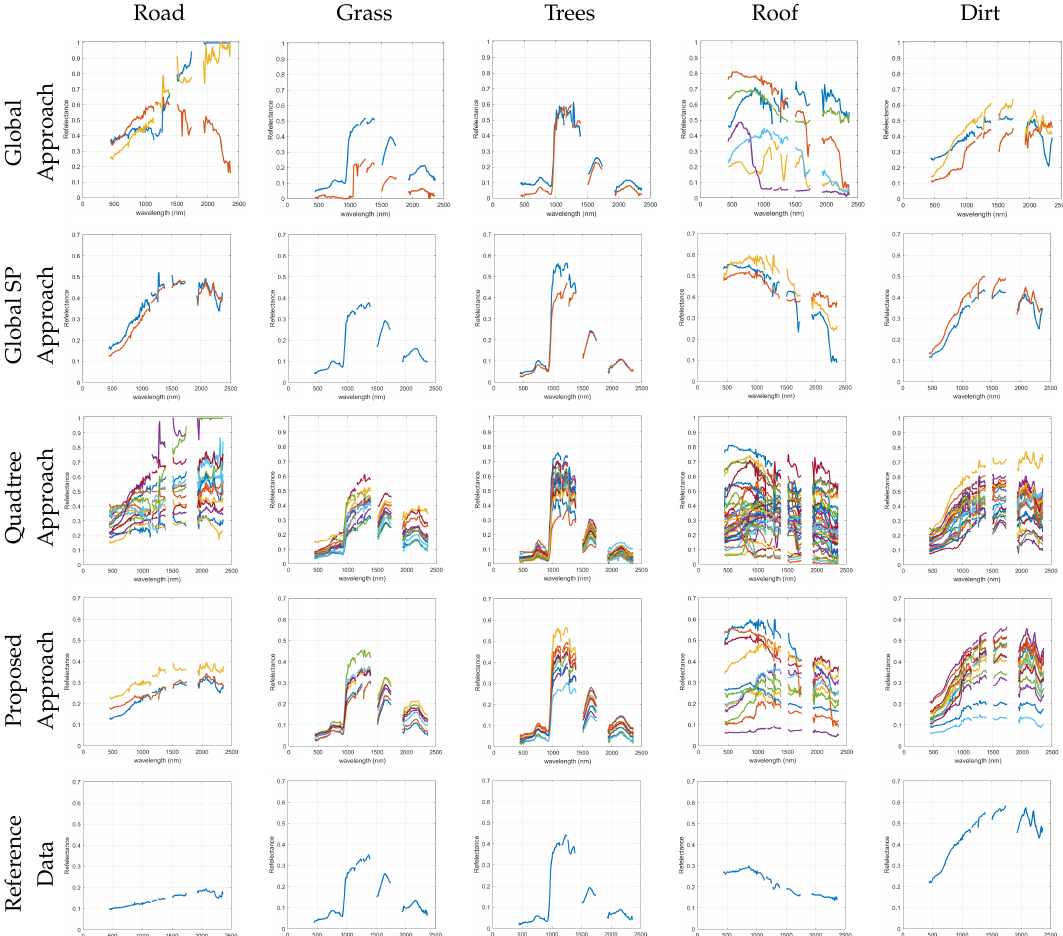
Figure 30. Comparison of extracted endmembers by different approaches with the proposed method and reference data.